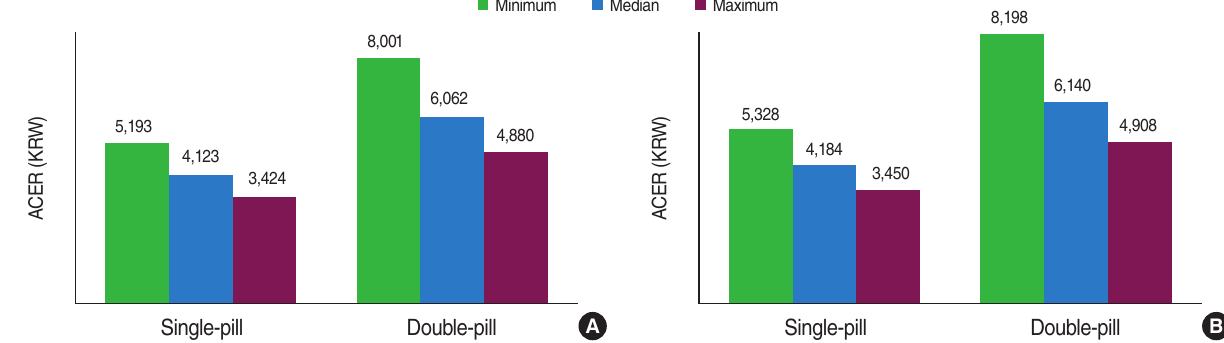
Figure 2. ACER based on adjusted odds ratios (A) and unadjusted odds ratios (B) in sensitivity analysis. ACER, average cost-effectiveness ratio; KRW, Korean